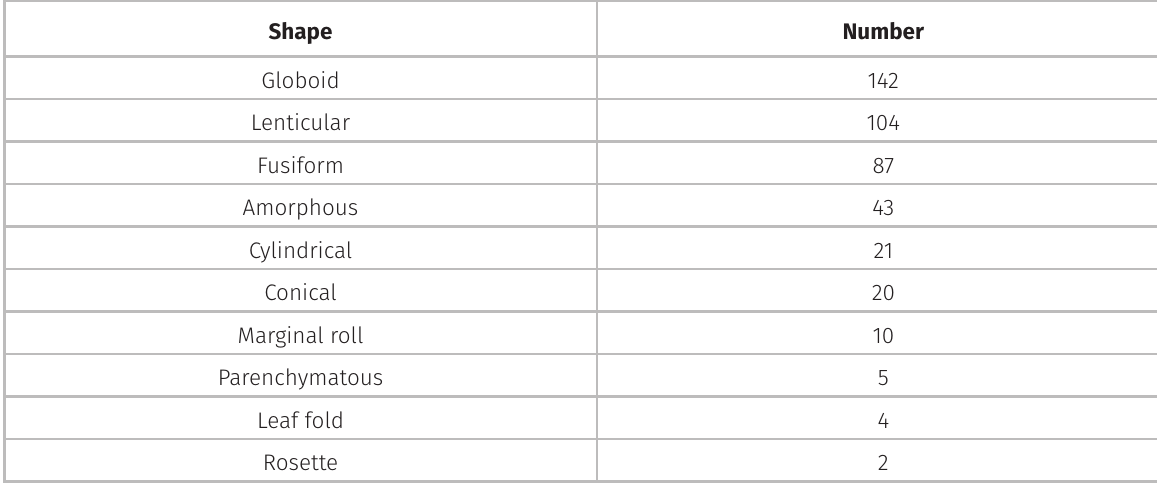
Table III. Numbers of Fabaceae taxa hosting galls in different Brazilian phytogeographical domain. Biome N° of genera N° of species in Brazil N° of host species Amazon Forest 164 1,144 44 73 Atlantic Forest 156 1,005 47 89 Caatinga 128 609 22 138 1,263